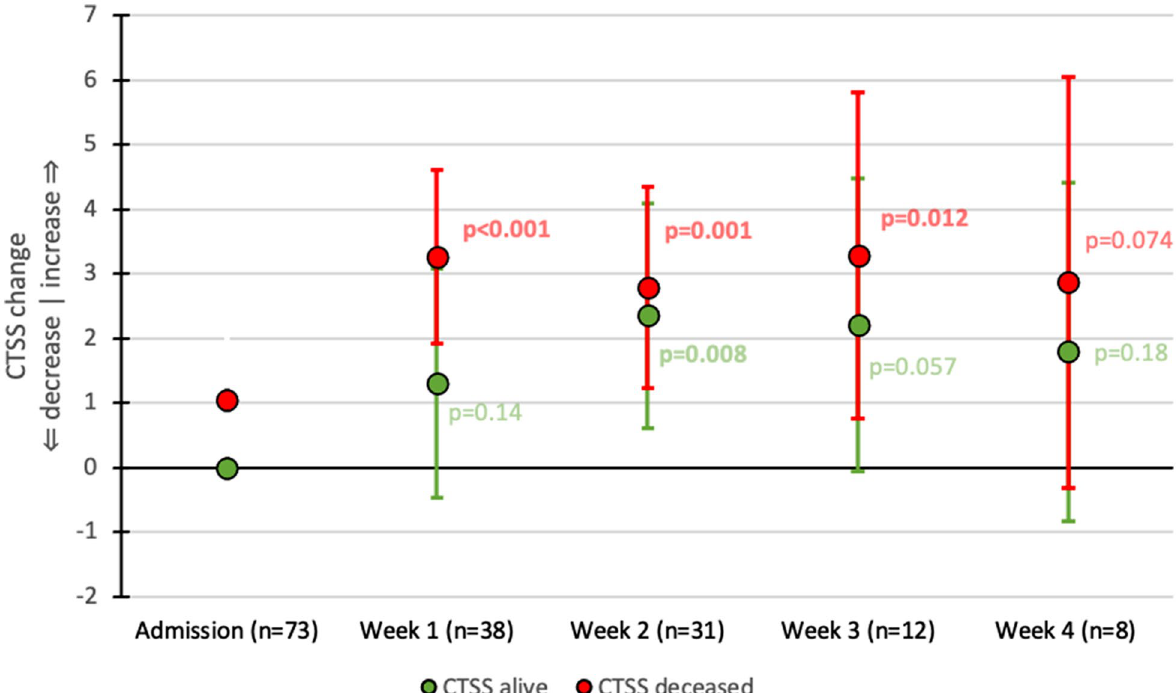
Fig. 5 CTSS changes over time compared to admission. CTSS: Computed tomography severity score. Each point represents the mean score change compared to respective admission with its 95% confidence interval. Green points: patients who survived. Red points: patients who died. P values at follow-up points should be interpreted as the significance of the change of that particular point compared to baseline. Significant p values are in bold. At admission, there was no difference between the CTSS of patients who survived until discharge or died during admission ( p